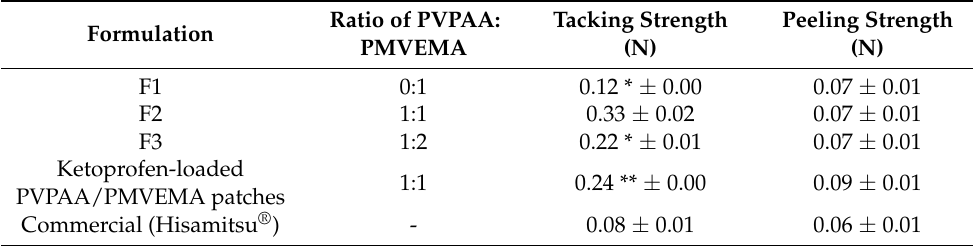
Table 2. Adhesive properties of the PVPAA/PMVEMA patches (F1–F3), the ketoprofen-loaded patches, and the commercial patch. * Statistically significant difference compared with F2 ( p < 0.05), ** Statistically significant difference compared with the commercial ketoprofen patches ( p < 0.05).